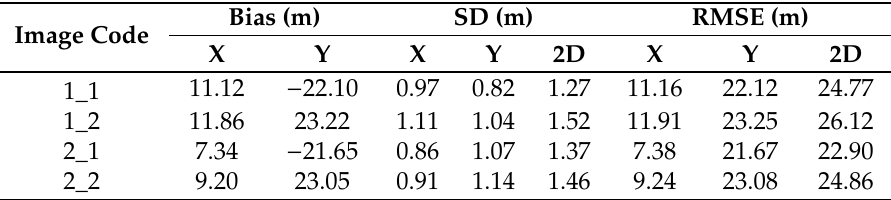
Table 2. Direct geopositioning accuracy at 102 ICPs (without GCPs) given as bias, standard deviation (SD) and RMSE for the four single Deimos-2